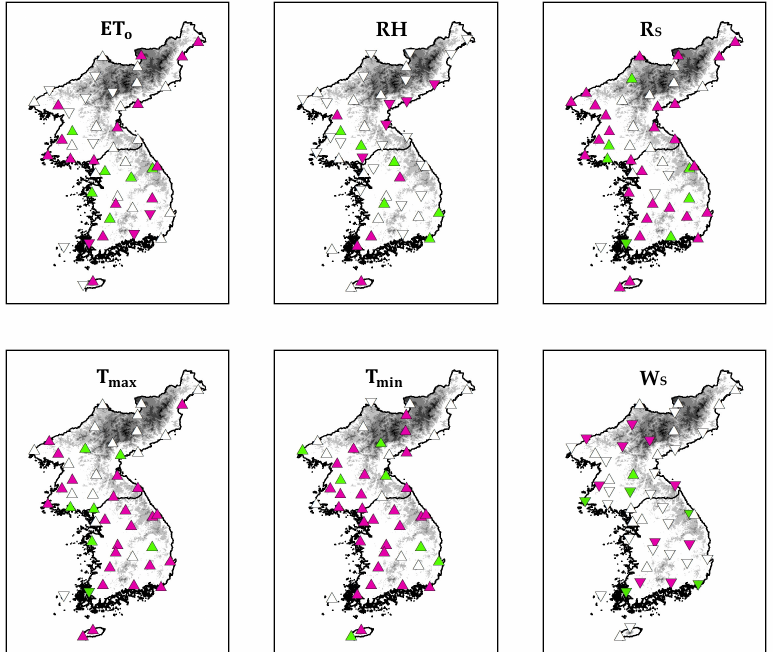
Figure 4. Spatial distribution of the annual trend of stations for ET o and meteorological variables over the Korean Peninsula (1980–2021). Upward and downward triangles define increasing and decreasing trends, respectively. The pink color indicates 95% confidence level, the green color indicates 90% confidence level, and white color indicates the trend is not significant. Table 5. Identification of the significant increasing, decreasing, and non ‐ significant trends of ET (cid:2925) and meteorological variables on seasonal and annual scales. Mountain Plain West Coast East Coast Period